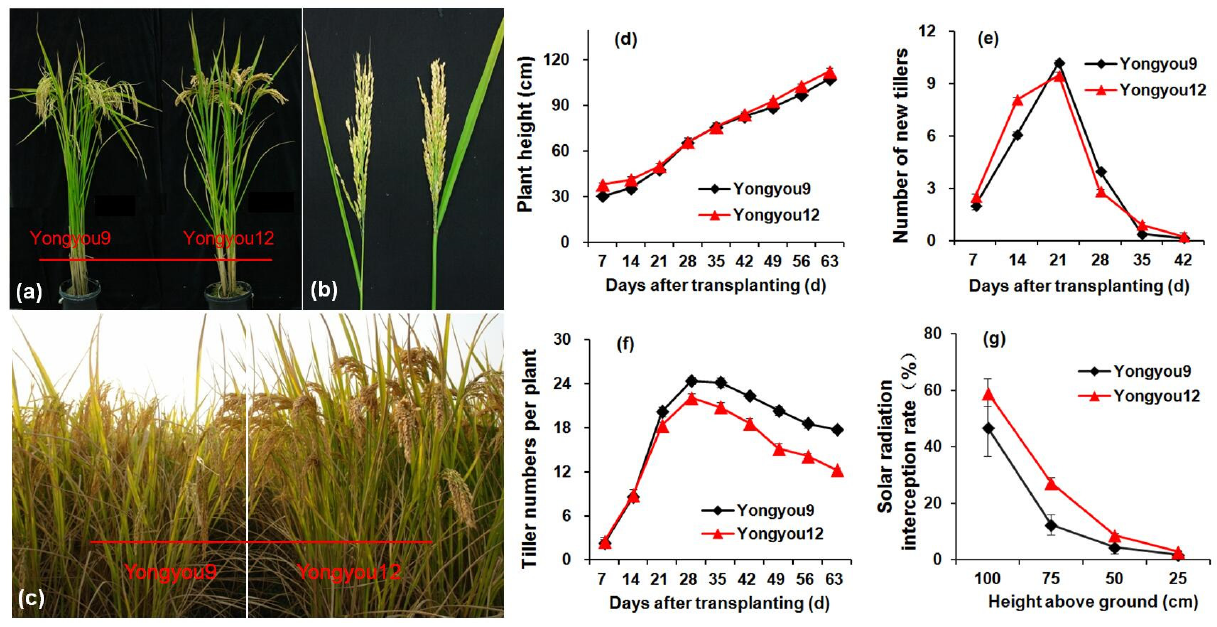
Figure 4. Rice plant morphology, plant height, tiller numbers, and canopy solar radiation: ( a ) and ( b ) plant morphology and panicle morphology; ( c ) field performance of rice; ( d ) plant height; ( e ) new tiller numbers; ( f ) tiller numbers per plant; ( g ) canopy light interception. Error bars denote ± standard deviation ( n = 3).